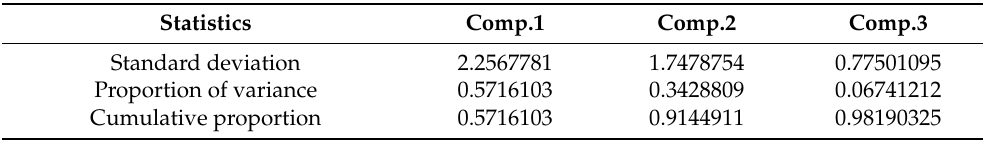
Figure 15. Wavelength projection 454 nm, 510 nm, 514 nm, 526 nm, 738 nm, 886 nm, 902 nm, 914 nm, 962 nm for Ambrosia artemisiifolia , Atriplex tatarica , Glycyrrhiza glabra , Euphorbia seguieriana , and Setaria pumila. Table 11. The value of the dispersion of the main components of the projection at wavelengths of 454 nm, 510 nm, 514 nm, 526 nm, 738 nm, 886 nm, 902 nm, 914 nm, 962 nm for Ambrosia artemisiifolia , Atriplex tatarica , Glycyrrhiza glabra , Euphorbia seguieriana , and Setaria pumila. Statistics